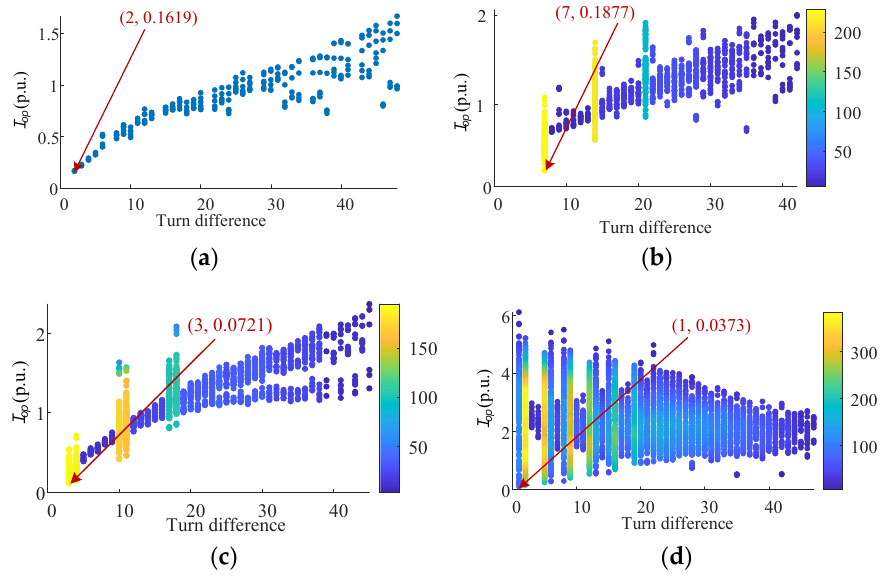
Figure 14. When s = − 0.01, the simulation results of all possible internal short ‐ circuit faults in rotor